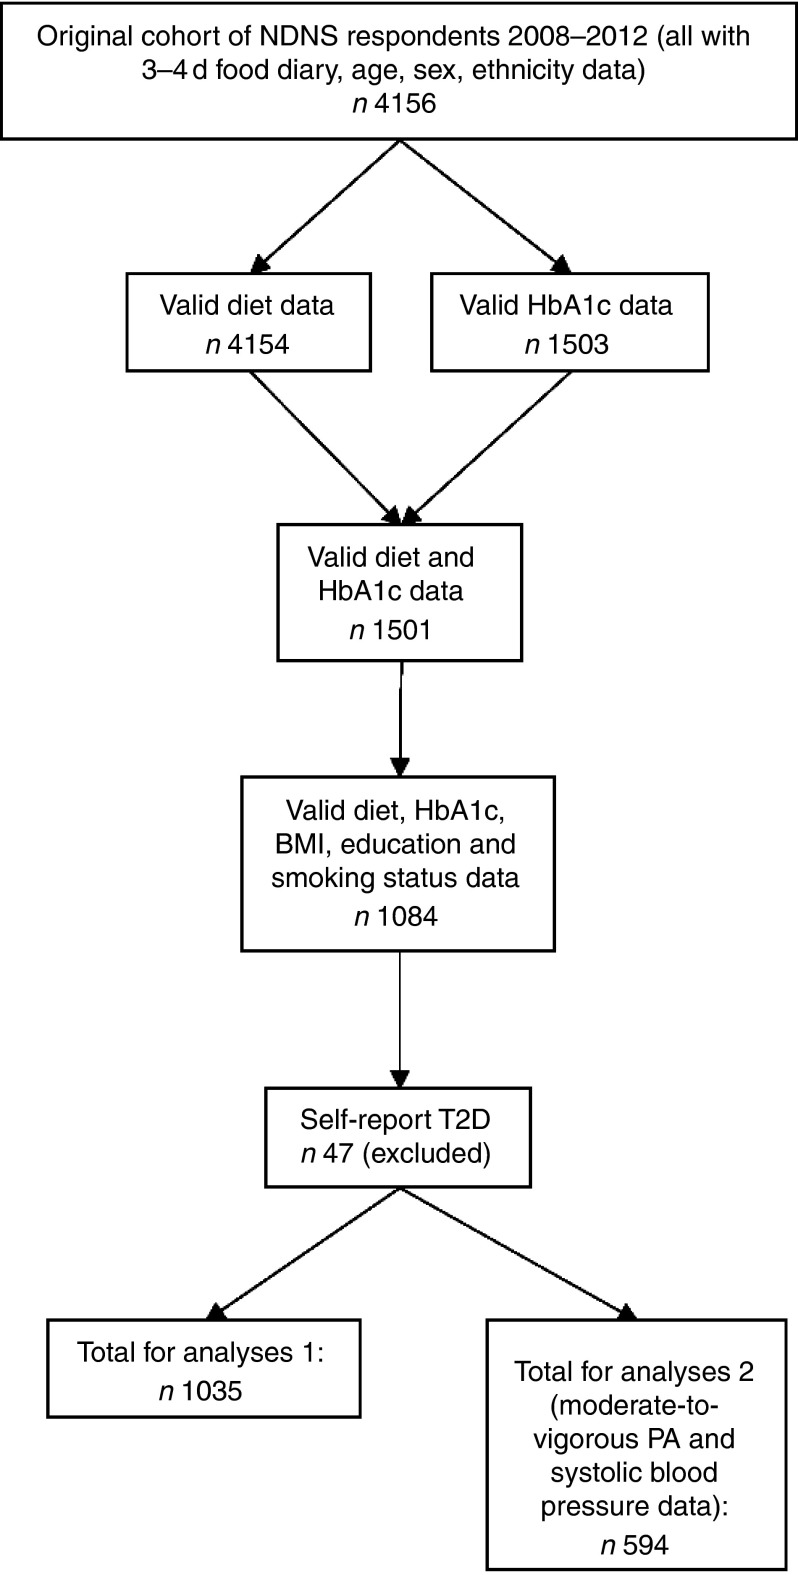
Flow chart of participant inclusion. NDNS, National Diet and Nutrition Survey;
HbA1c, glycated Hb; PA, physical activity; T2D, type 2 diabetes.